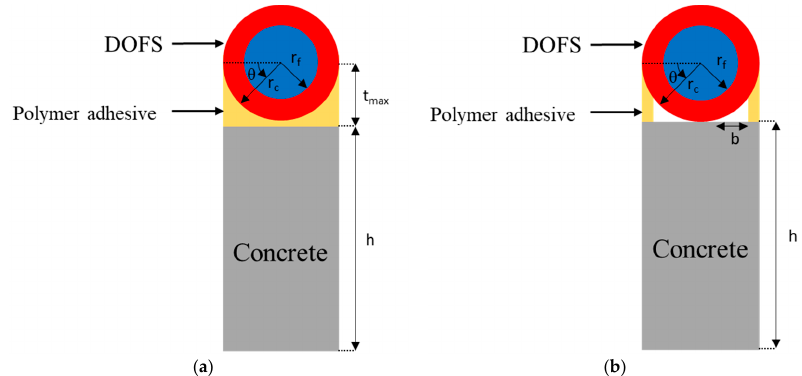
Figure 3. Schemes of the theoretical models developed by ( a ) Kim et al. [31] and ( b ) Her et al. [32].